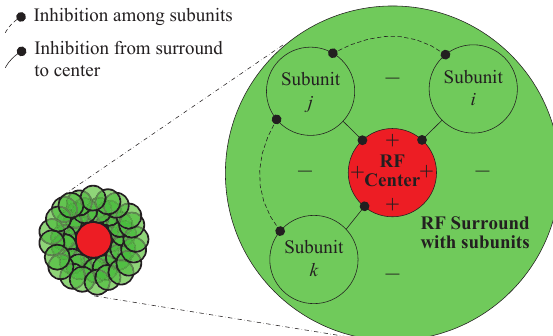
Figure 3. Illustration of the spatial structure of the non-classical receptive field (nCRF) model of ON-type, containing an excitatory center and an inhibitory surround with multiple